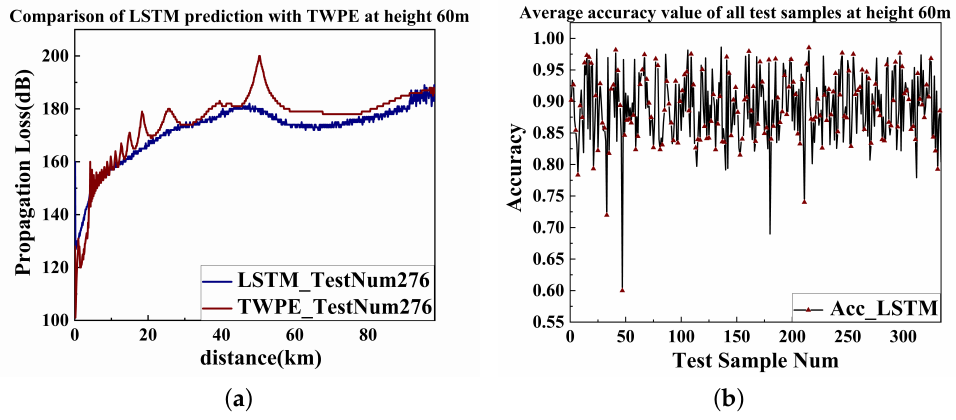
Figure 31. LSTM prediction at a height of 60 m and accuracy distribution. ( a ) PL prediction using LSTM at an antenna height of 60 m. ( b ) LSTM of PL at a height of 60 m accuracy on test samples.